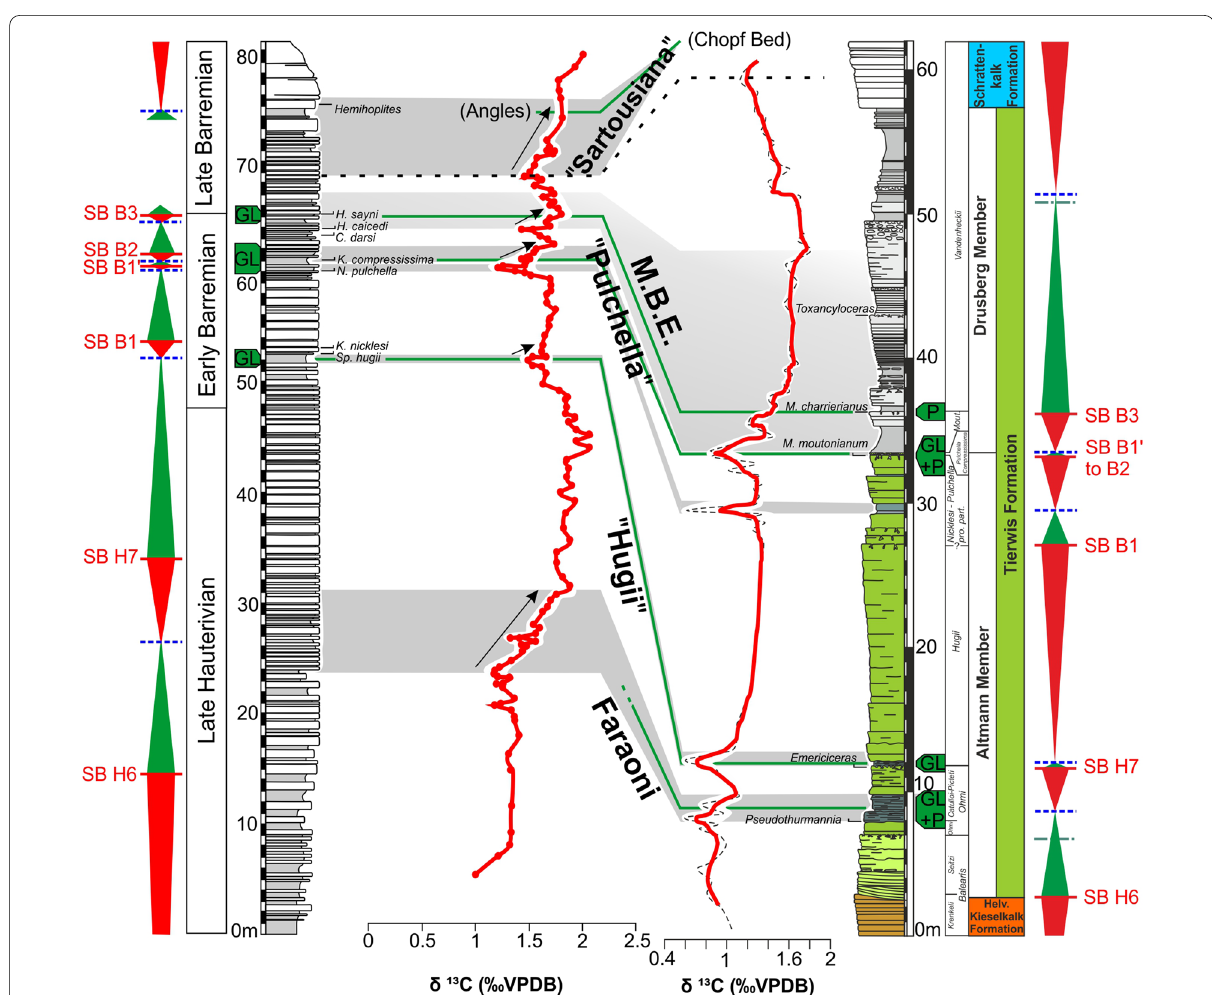
Fig. 17 Correlation figure between the Tierwis section and the Clos de Barral section (SE France) based on chemo-, bio- and sequence-stratigraphy and on condensed beds. Grey intervals correspond to environmental perturbations and associated laminated, organic-rich muds into the basins. Green lines indicate the glauconite and phosphate-rich beds. Lithological log of the Clos de Barral section and associated sequence stratigraphic interpretation (modified), ammonites and δ 13 C curve are from Godet et al.